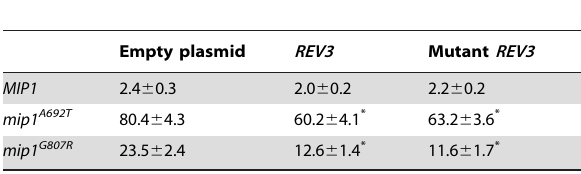
Table 5. Petite frequency in mip1 strains overexpressing REV3 or the mutagenized form of REV3